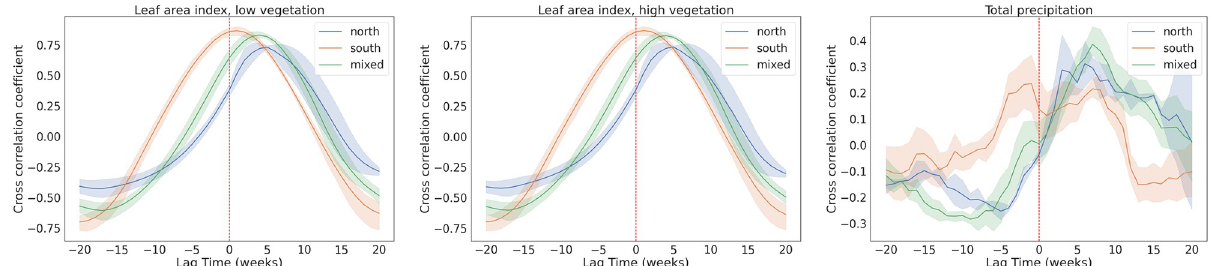
Fig 4. TLCC analysis for the low (left panel) and high (middle panel) vegetation indices and precipitation (right panel) variables with respect to the weekly tick-related hospital visits for the three federal region clusters investigated in this study. Each panel shows the averaged TLCC curve for the three